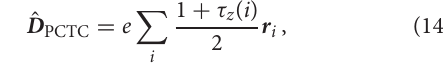
n - d spin rotation and using the E